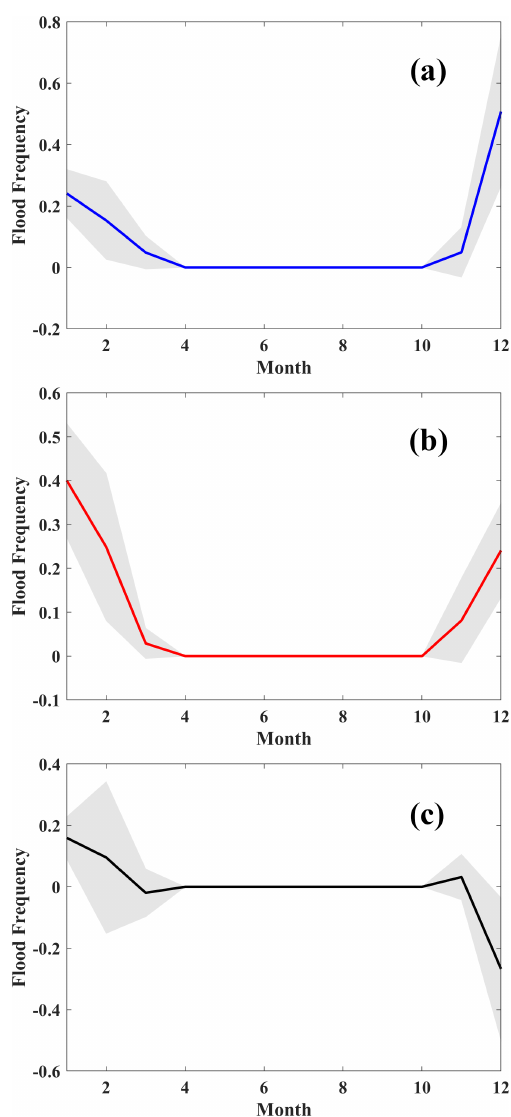
Figure 7. Multi-model mean of the monthly flood frequencies for the (a) historical and (b) future periods. Frequencies were calcu- lated by dividing the flood alerts detected in each month by the total number of alerts. Thus, the sum of the frequencies of all months is equal to 1. (c) Differences in flood frequency between historical and future periods. Positive (negative) values indicate an increasing (decreasing) of flood frequency in the future. Gray shadow areas represent multi-model